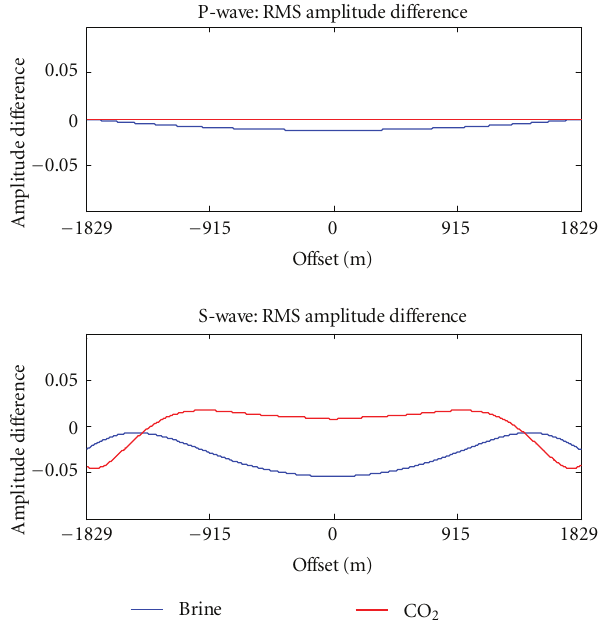
Figure 21: RMS amplitude di ff erence at the Morrow A sandstone top for the synthetic seismic modeling of the P- and S-wave gathers.